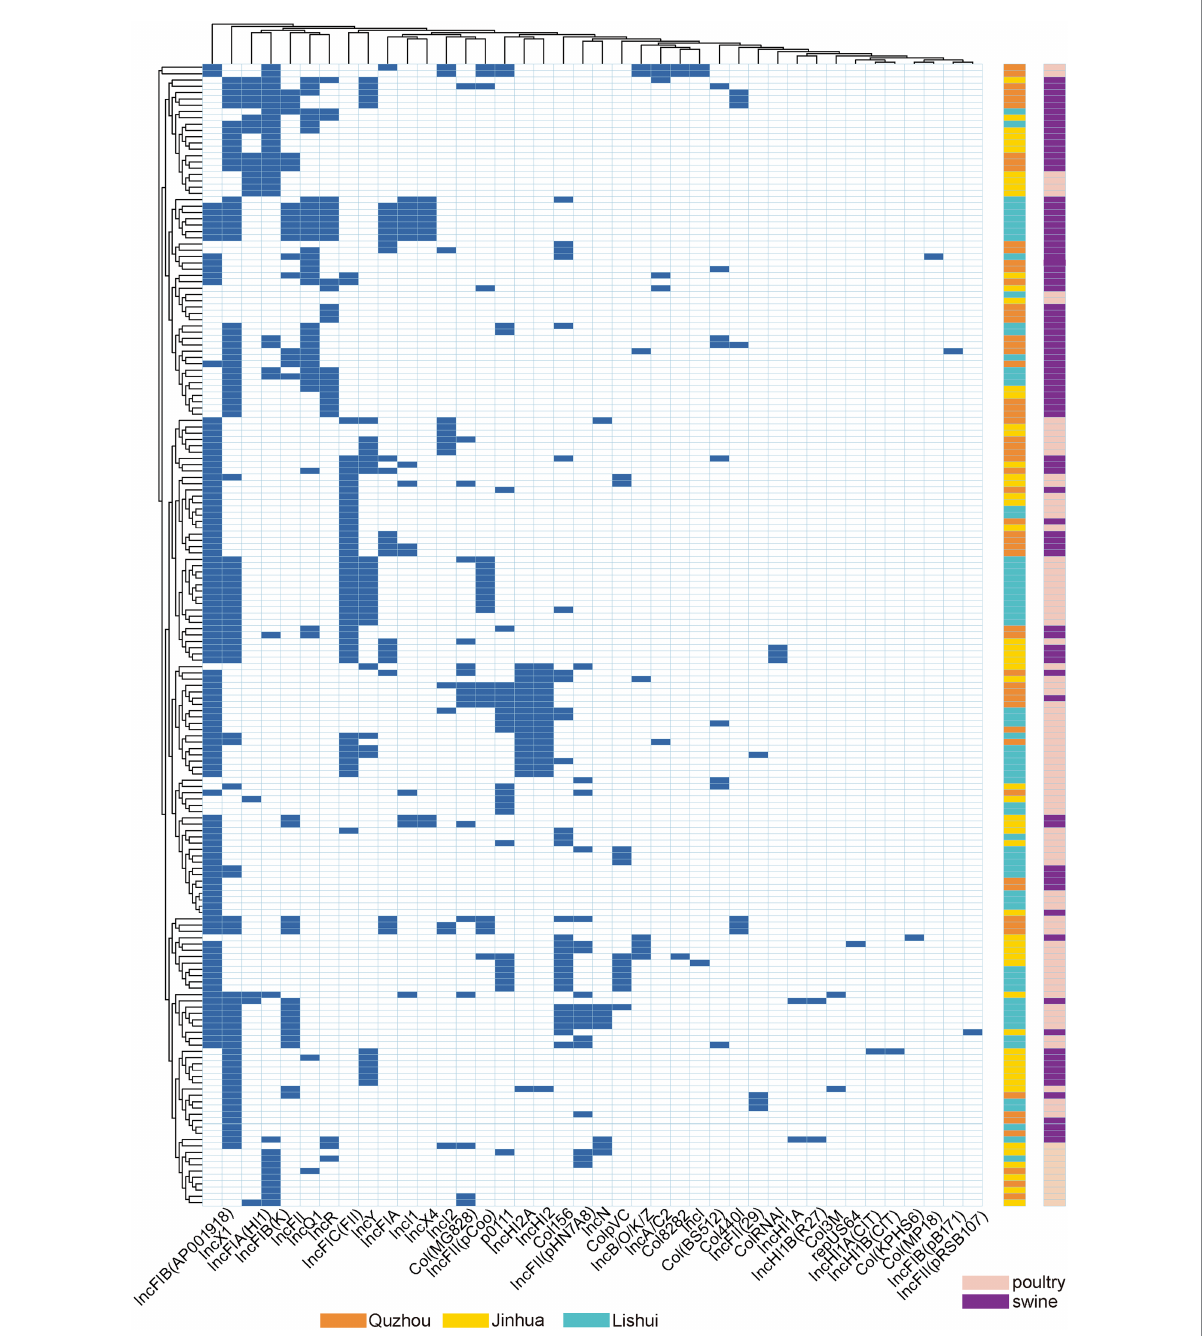
FIGURE 4 Dendrogram of hierarchical clustering heatmap of the 181 isolates and 40 plasmid replicons. Y-axis is the isolate number, and x-axis is the selected resistance genes identified. Non-expression of resistance is a white background and resistance phenotype is a blue background. Orange indicates isolates were isolated from Quzhou samples, aqua blue indicates isolates were isolated from Lishui, and bright yellow indicates isolates were isolated from Jinhua. Purple indicates that the strain is isolated from pig anal swab samples, and green indicates that the strain is isolated from bird anal swab